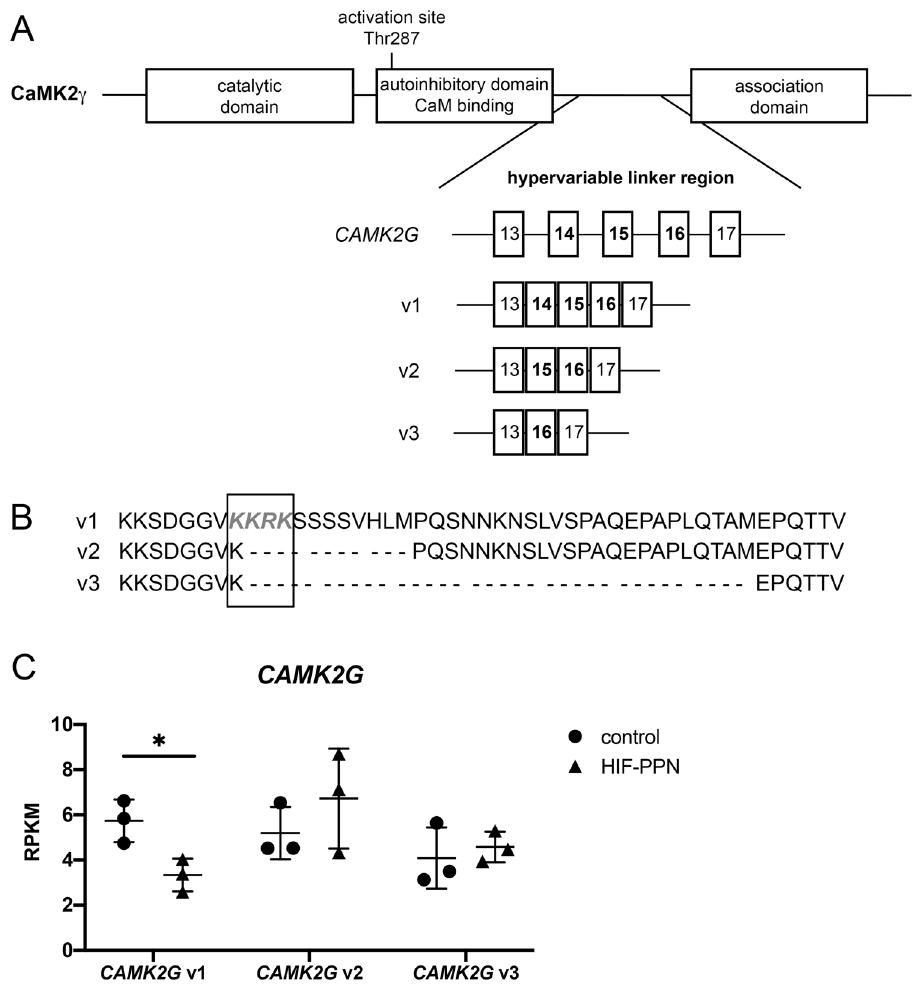
Figure 2. CAMK2G splicing is altered in HIF-PPN hearts. ( A ) Schematic depicting CAMK2γ functional domains and its splice variants. The isoforms differ within the hypervariable linker region, with variant 1 (v1) retaining all exons. Variants 2 (v2) and 3 (v3) lack exon 14 or exons 14–15, respectively. ( B ) Amino acid sequences for CaMK2γ isoforms within the hypervariable region. Variant 1 (v1) is the longest isoform and retains a nuclear localization sequence (KKRK, highlighted in gray and outlined by black box) that is spliced out of the other two isoforms. ( C ) Expression of CAMK2G splice variant RNA 3 days after HIF-PPN induction as assessed by RNA sequencing. Data displayed as reads per kilobase of exon per million reads mapped (RPKM) and compared to control mice (on dox). n = 3 per group. Student’s t test. * p =